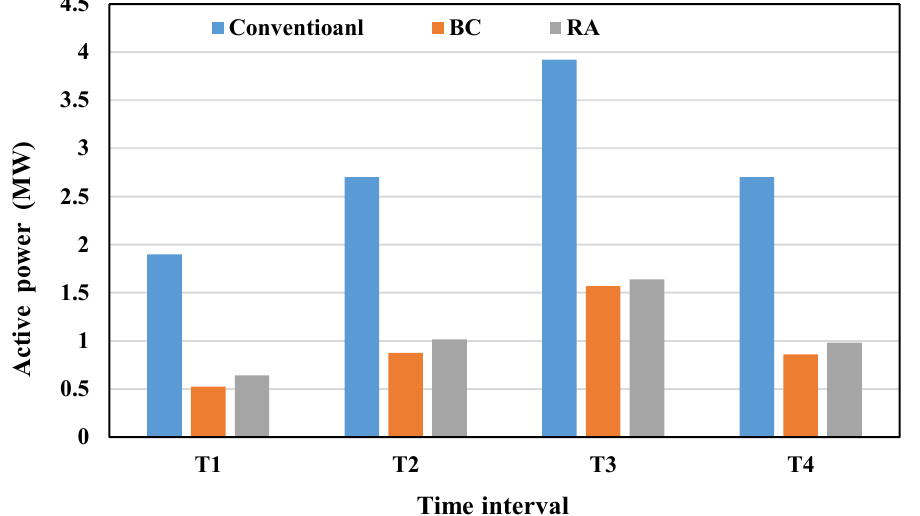
Figure 7. Imported active power from the main grid in different cases (on-grid operation mode).